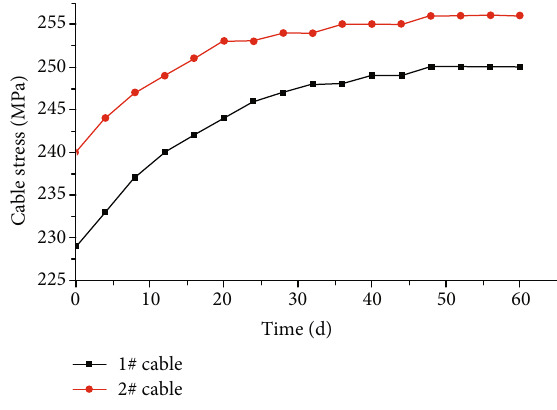
Figure 18: Stress condition of the anchor